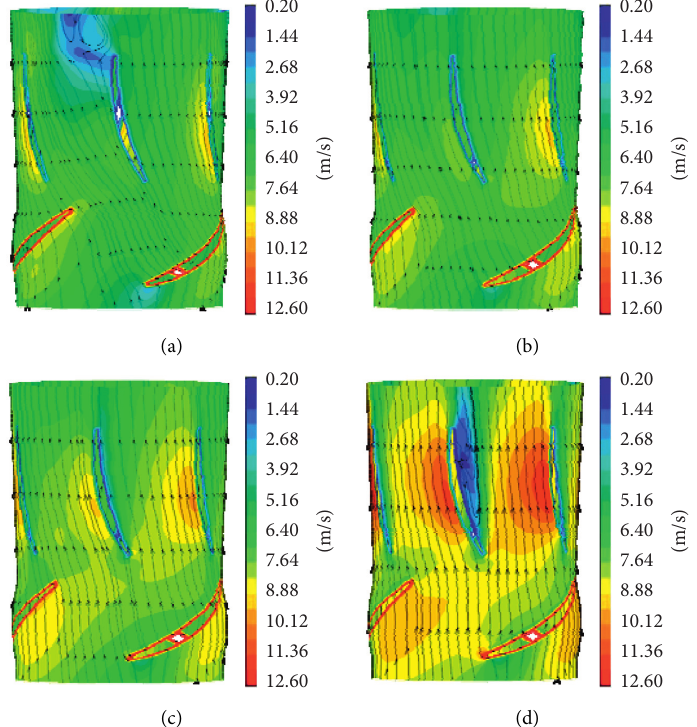
Figure 4: Flow fields in the pump segment under different conditions of discharge rates. (a) Q � 0.30m 3 /s, (b) Q � 0.35m 3 /s, (c) Q � 0.40m 3 /s, and (d) Q � 0.45m 3 /s.